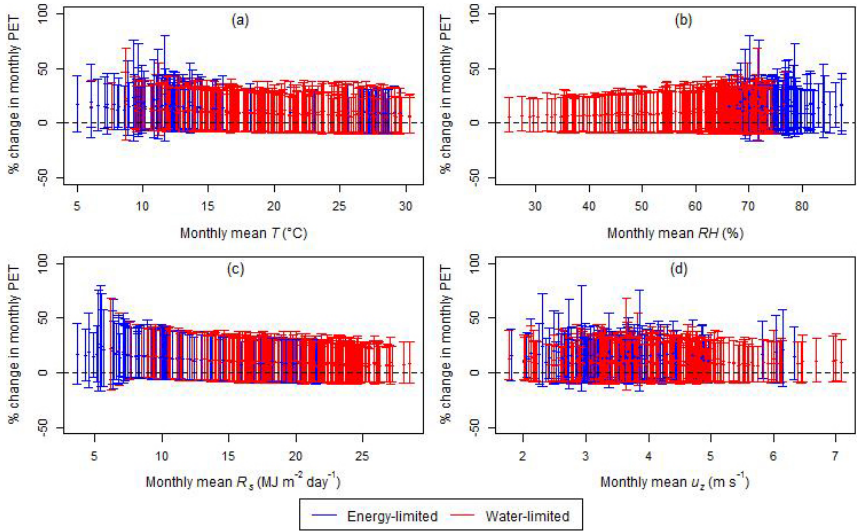
Figure 4. Range of monthly PET responses obtained from the Priestley–Taylor model, plotted against the monthly baseline levels of (a) tem- perature, (b) relative humidity, (c) solar radiation and (d) wind speed at 30 study sites. Each vertical line represents the range of all potential changes in PET in response to the full set of climate perturbations for a single month at a single location, with the mean represented by the point on the line. The classification of energy- and water-limited months is based on the corresponding monthly PET /P